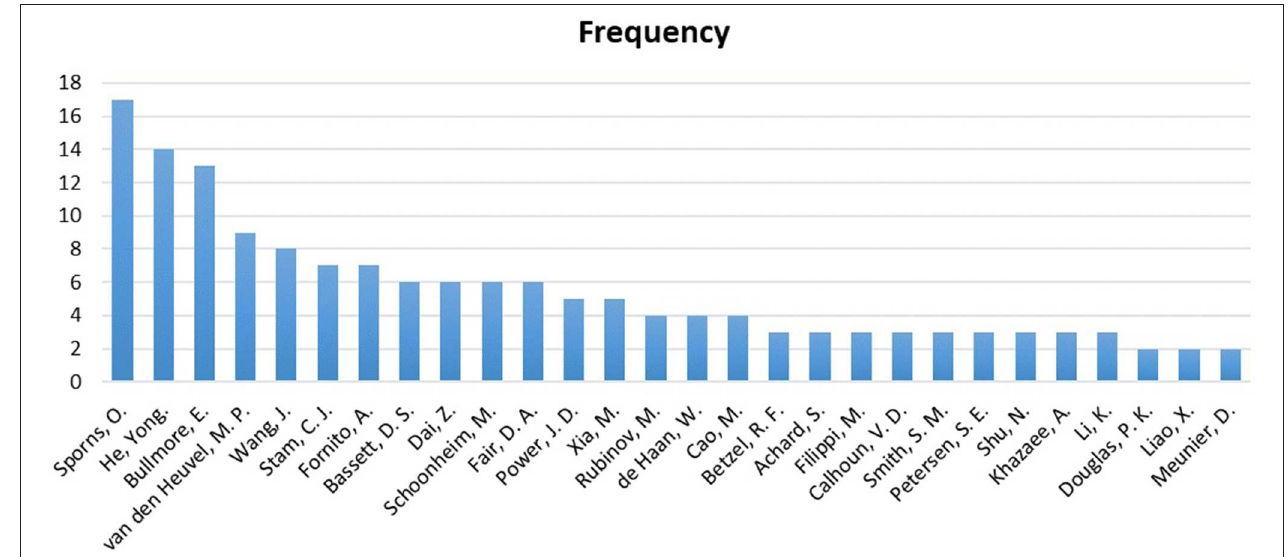
FIGURE 11 | Frequency of the authors in the